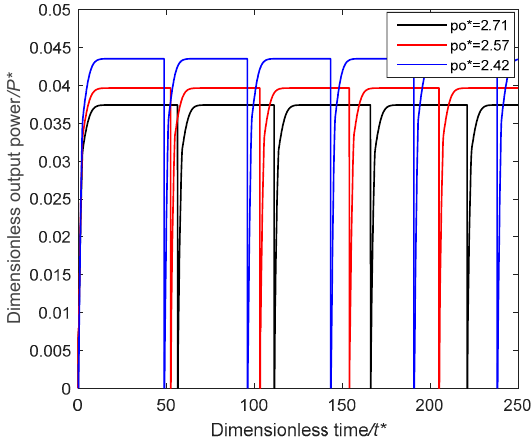
Figure 7. Dimensionless output power–time curves of the power system.